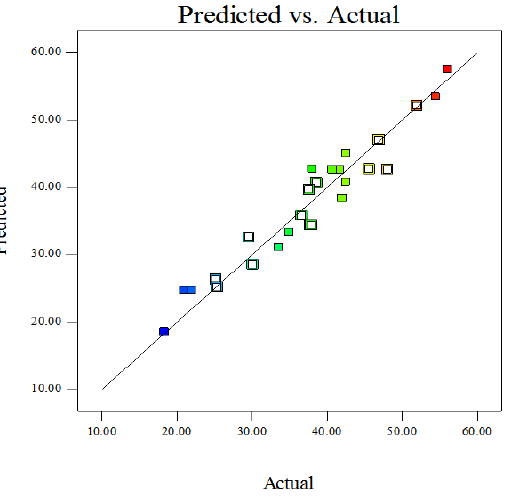
Figure 5. COD removal efficiency response surface model, predicted value vs. actual value.